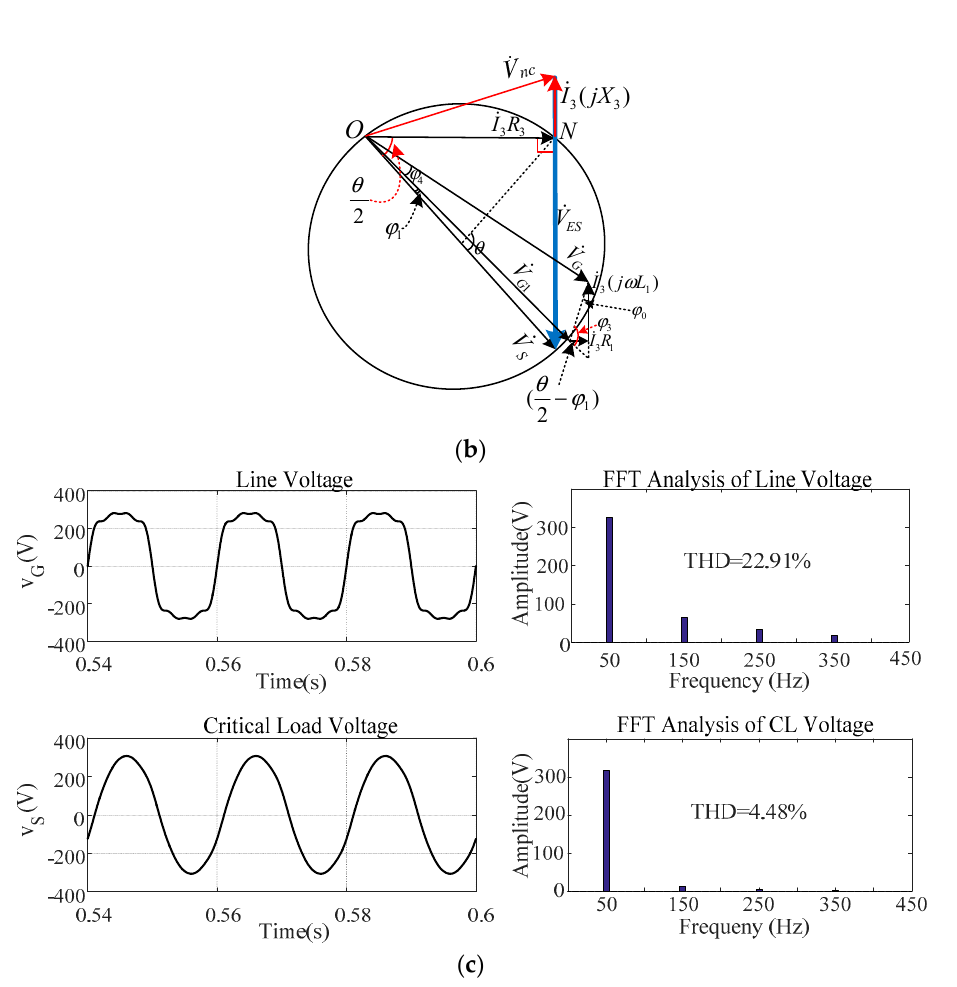
Figure 2. The existing δ control setup of the single-phase ES. ( a ) Control scheme. ( b ) Vector diagram of the δ control in the capacitive mode as an example. ( c ) Fast Fourier Transformation (FFT) analysis of grid voltage and critical loads (CL) voltage under distorted conditions. PR: proportional resonant; THD: total harmonic distortion; SPMW: sinusoidal pulse width modulation; RMS: root mean square.